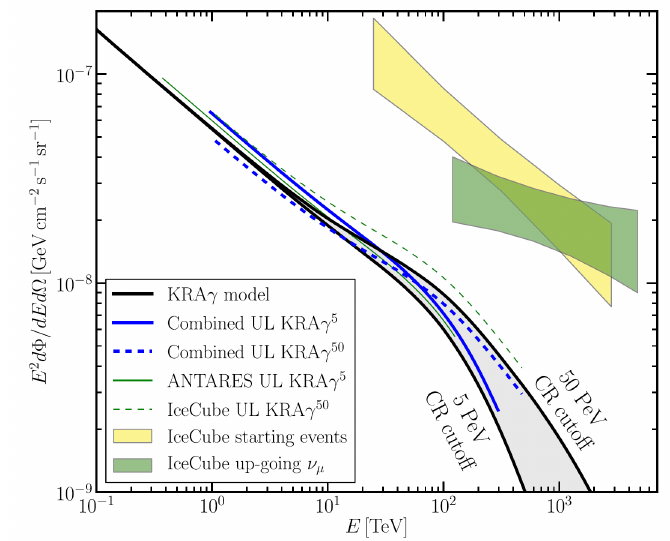
Figure 11. Combined upper limits from ANTARES and IceCube (at 90% confidence level, blue lines) on the three-flavor neutrino flux of the model of Galactic cosmic ray propagation (the black lines shows two values of the knee position). The boxes represent the diffuse astrophysical neutrino fluxes measured by IceCube using an isotropic flux template with starting events (yellow) and upgoing tracks (green)